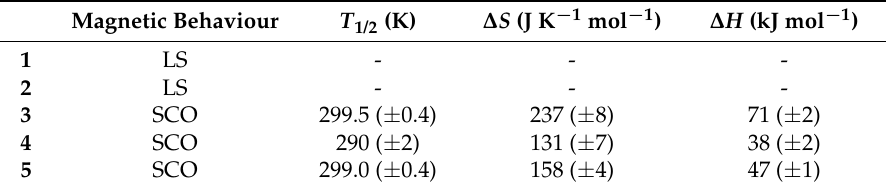
Table 2. Summary of SCO data for compounds 1 – 5